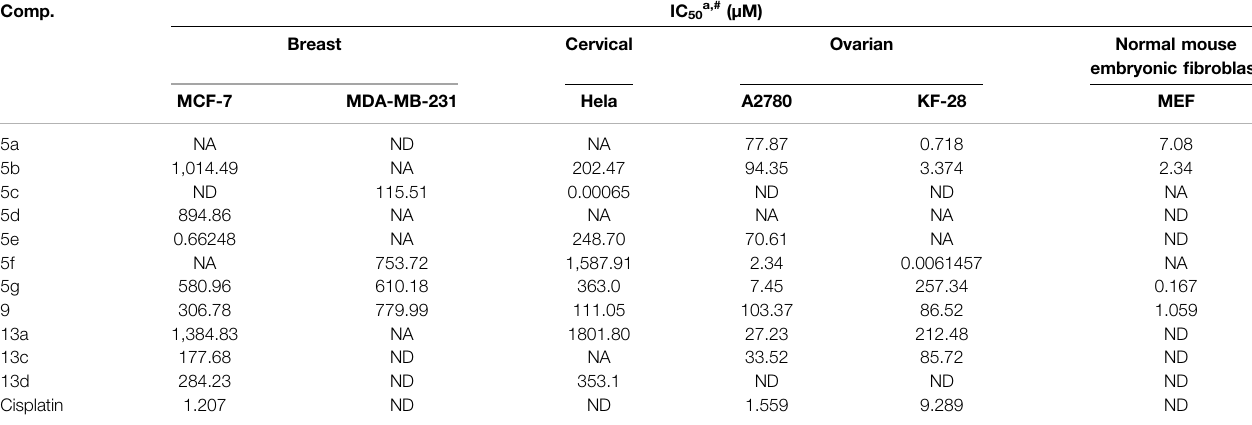
embryonic fi broblast